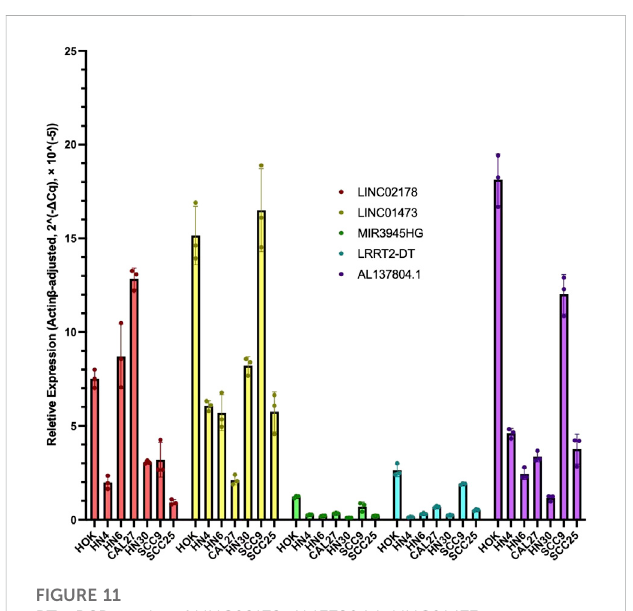
FIGURE 11 RT-qPCR results of LINC02178, AL137804.1, LINC01473, MIR3945HG, and LRRK2-DT in different kinds of HNSC cells compared to human oral